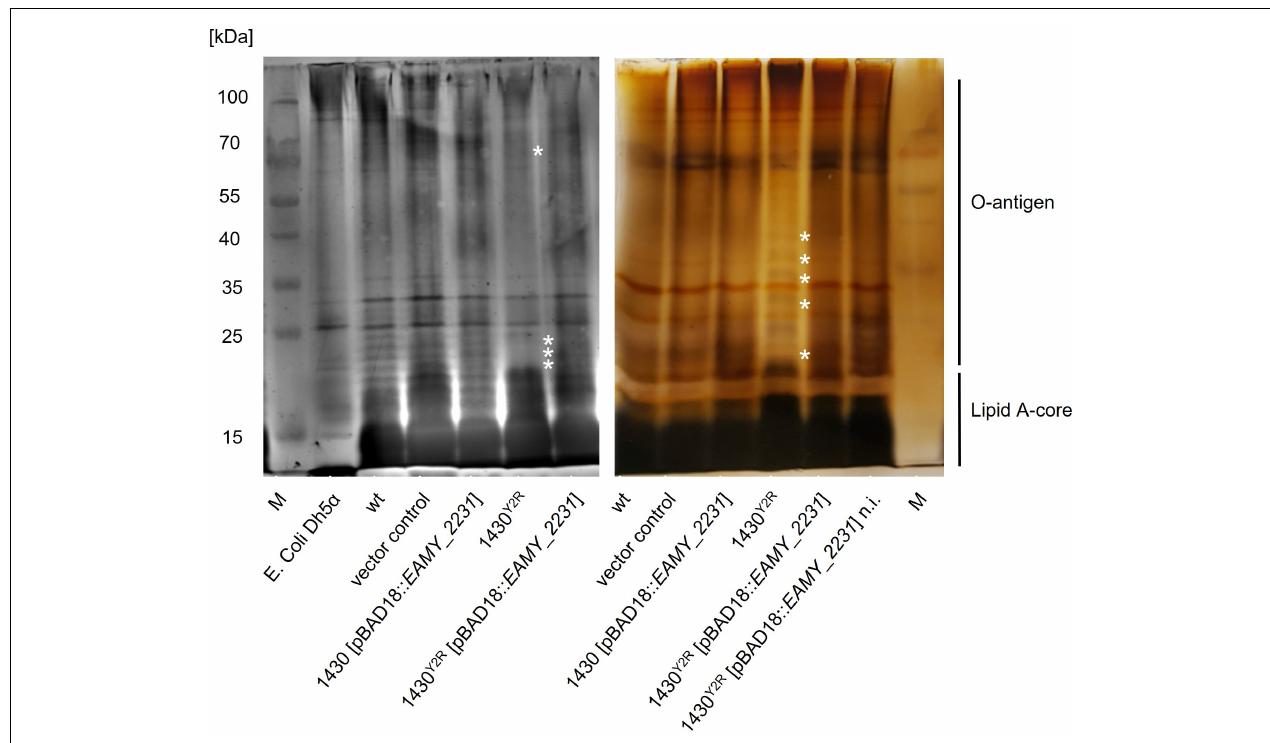
FIGURE 7 | SDS-PAGE analyses of extracted LPS. LPS of the wild type (wt), the empty vector control, 1430 [pBAD18: EAMY_2231 ], the 1430 Y 2 R strain, and the non-induced (n.i.) and induced complementation in 1430 Y 2 R [pBAD18: EAMY_2231 ] were silver stained to analyse alterations of the LPS banding pattern. Image of the left gel was taken by an Azure biosystems C300, whereas the image on the right was taken by a standard photo camera. The asterisk indicates changes in the LPS banding pattern of the 1430 Y 2 R strain.